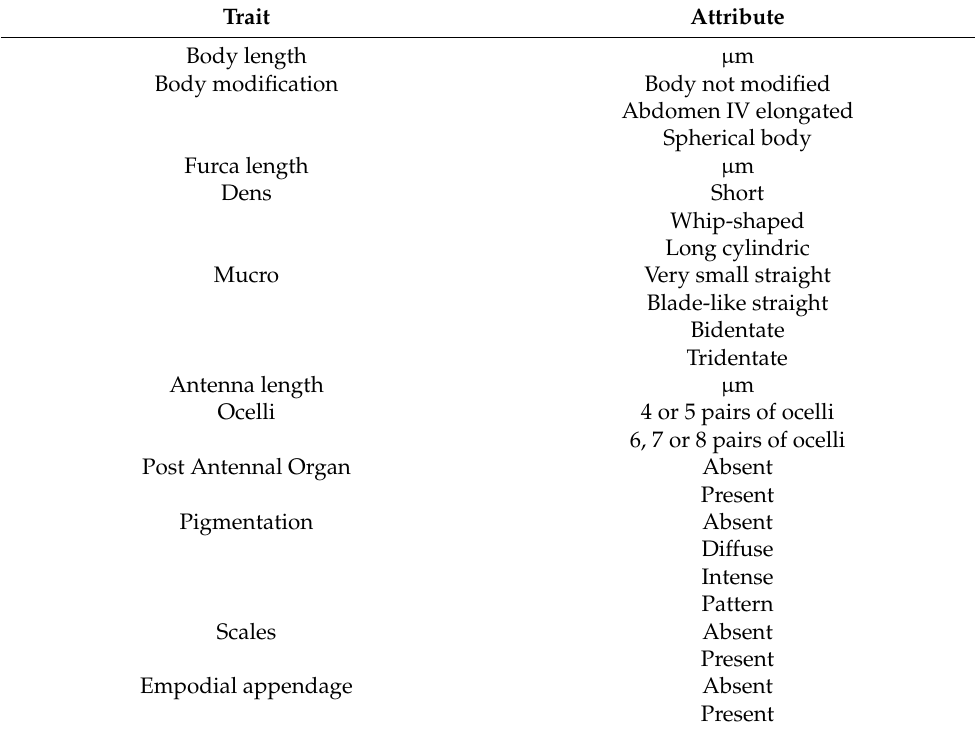
Table 1. Description and attributes of morphological traits, considered for the trait-based approach of springtails communities. Trait Attribute Body length µ m Body modification Body not modified Abdomen IV elongated Spherical body Furca length µ m Dens Short Whip-shaped Mucro Very small straight Blade-like